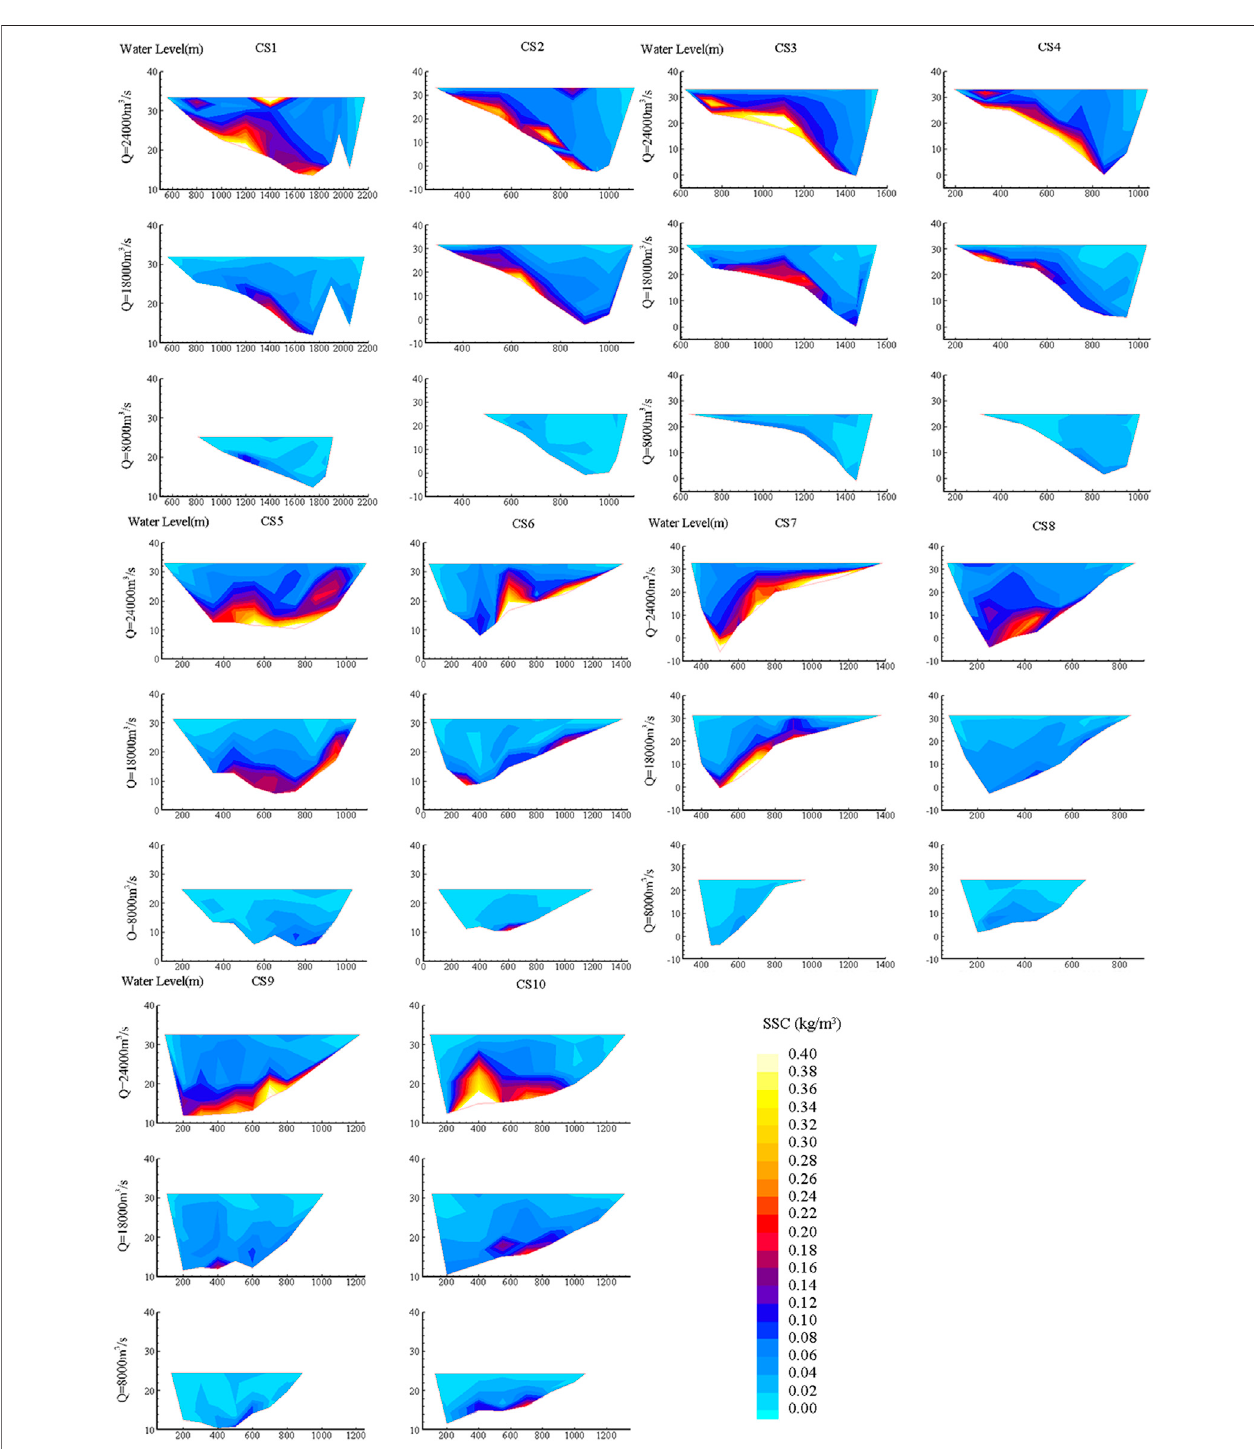
FIGURE 7 | Contour map of suspended sediment concentration (SSC) in Bend A and Bend B at different discharges. The suspended sediment concentration varies between 0.00 and 0.40 kg/m 3 , and the isoline interval is 0.02 kg/m 3 .